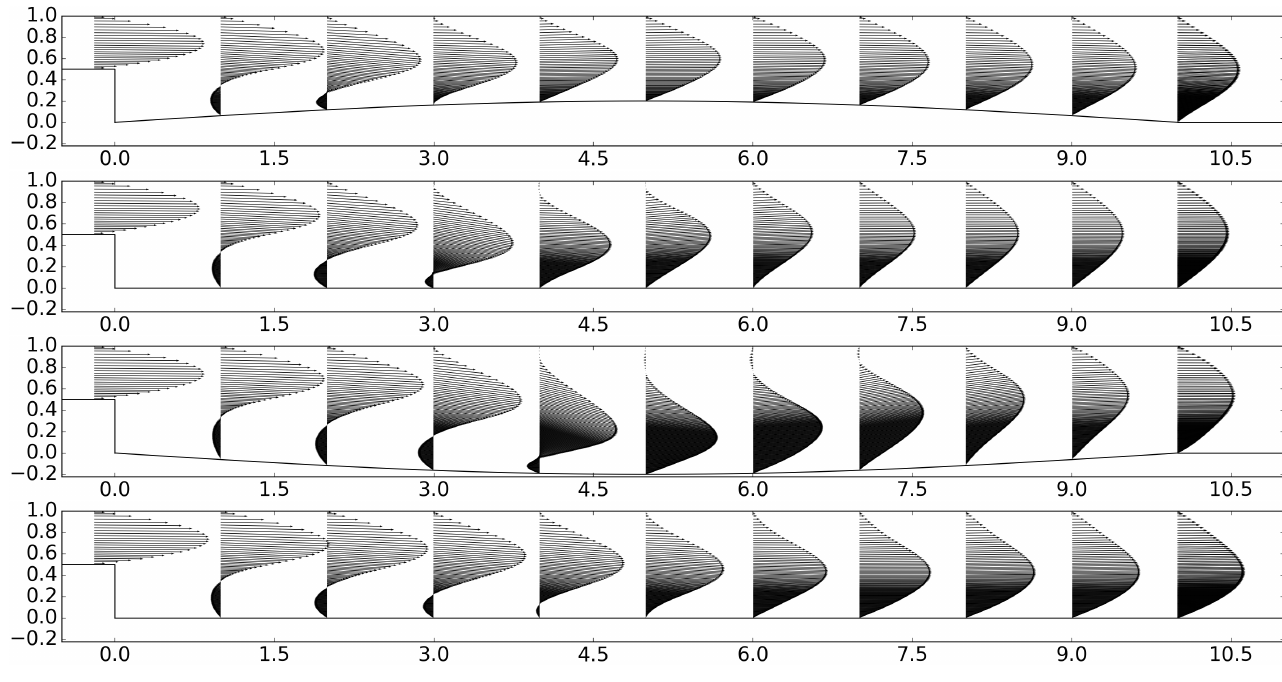
Figure 12. Computed velocity fields for t = 0, t = T /4, t = T /2, t = 3 T /4, respectively, during a period T , for prescribed motion of the control surface with A = 0.2, ω = 0.05, and l = 10. The inflow is oscillating with α = 0.05. The Reynolds number is 400.